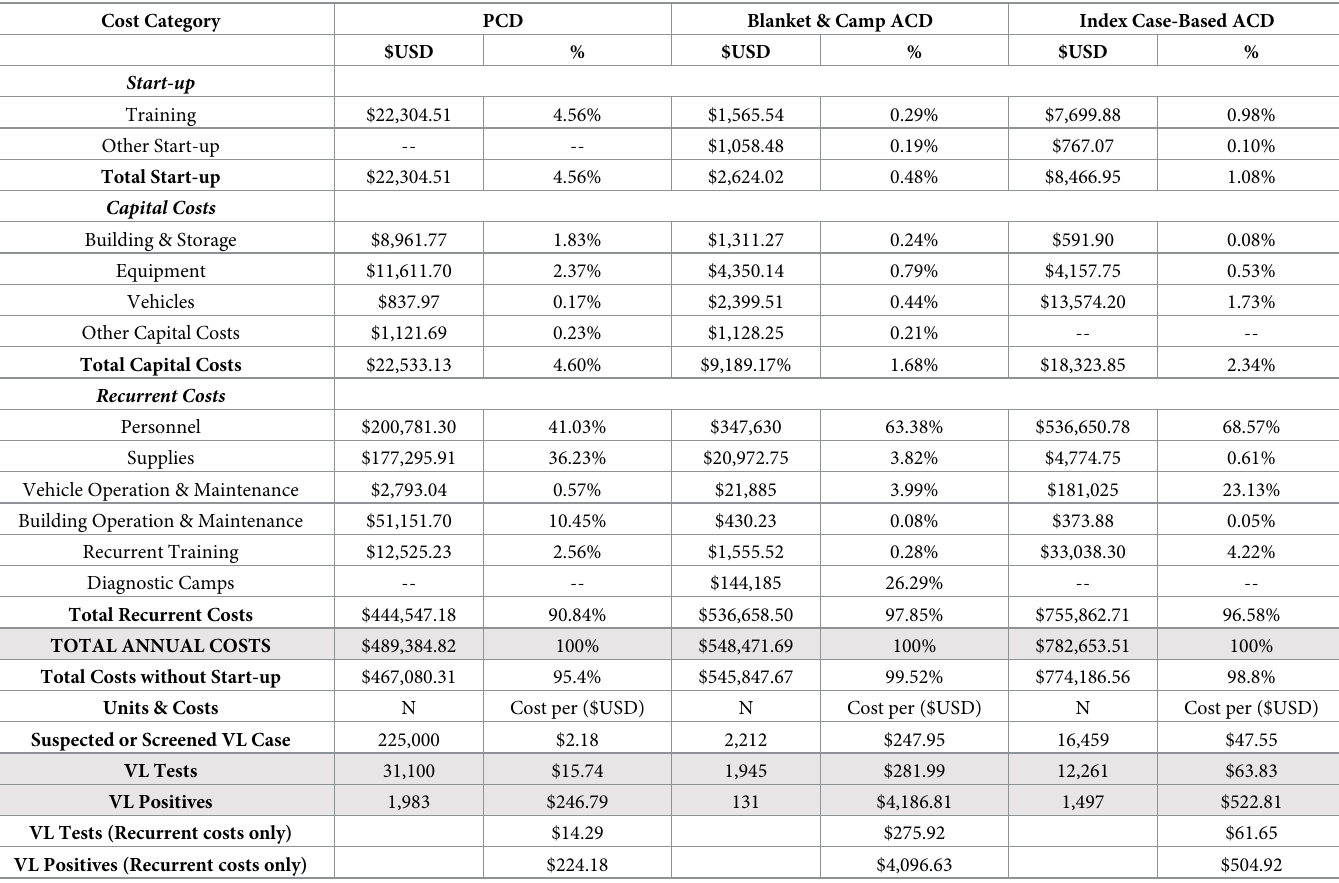
Table 1. Cost Summary and outputs of PCD, blanket & camp ACD, and index case-based ACD for VL during